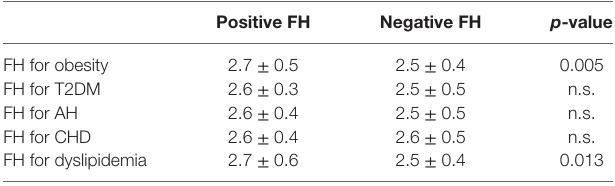
Table 1 | BMI SD distribution (mean ± SD) in children according to familial risk factors.